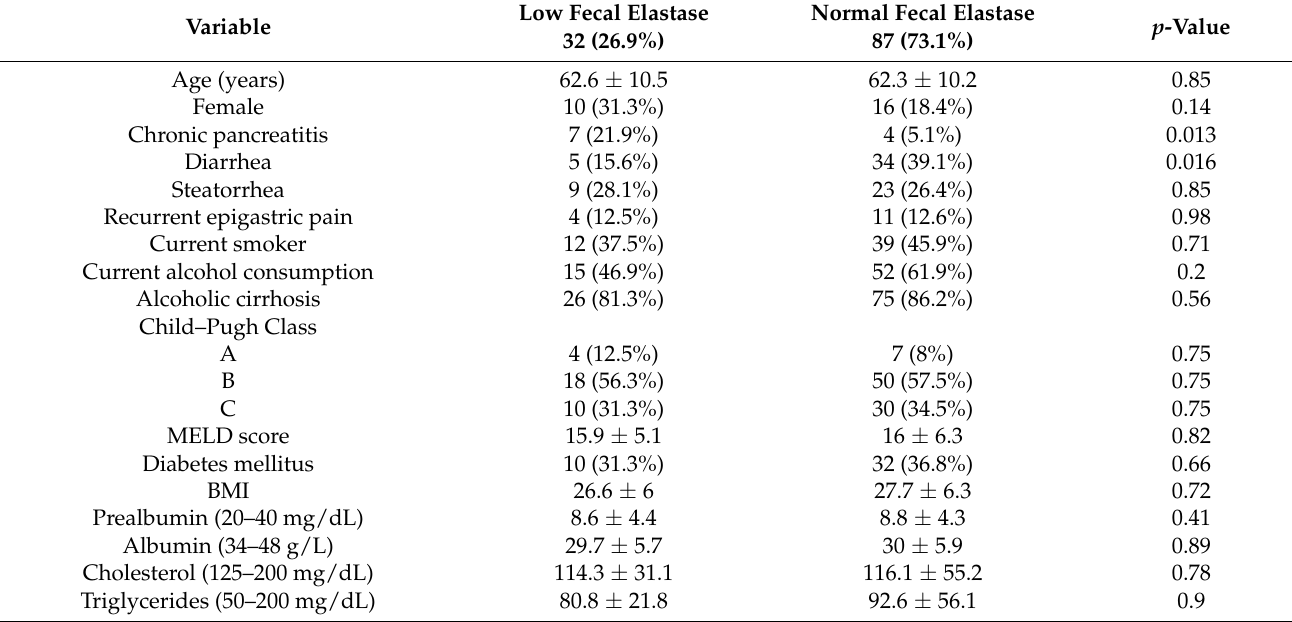
Table 3. Exocrine pancreatic insufficiency vs. normal fecal elastase ( n =